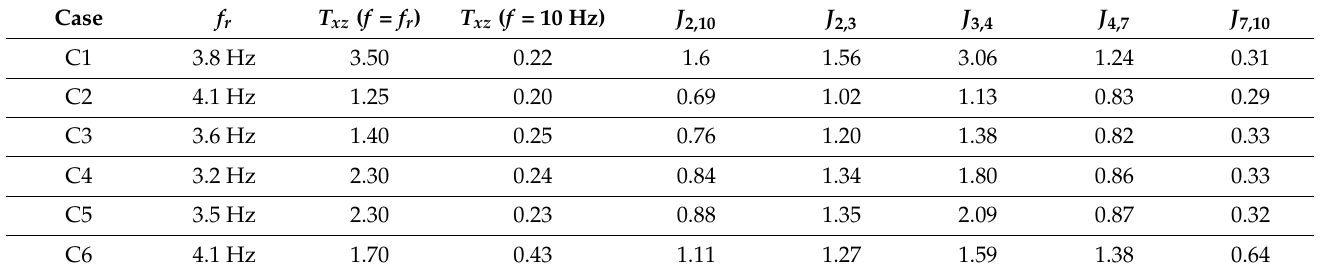
Table 4. Resonant frequency f r , transmissibility T xz ( f ), and performance index J fa,fb in cases